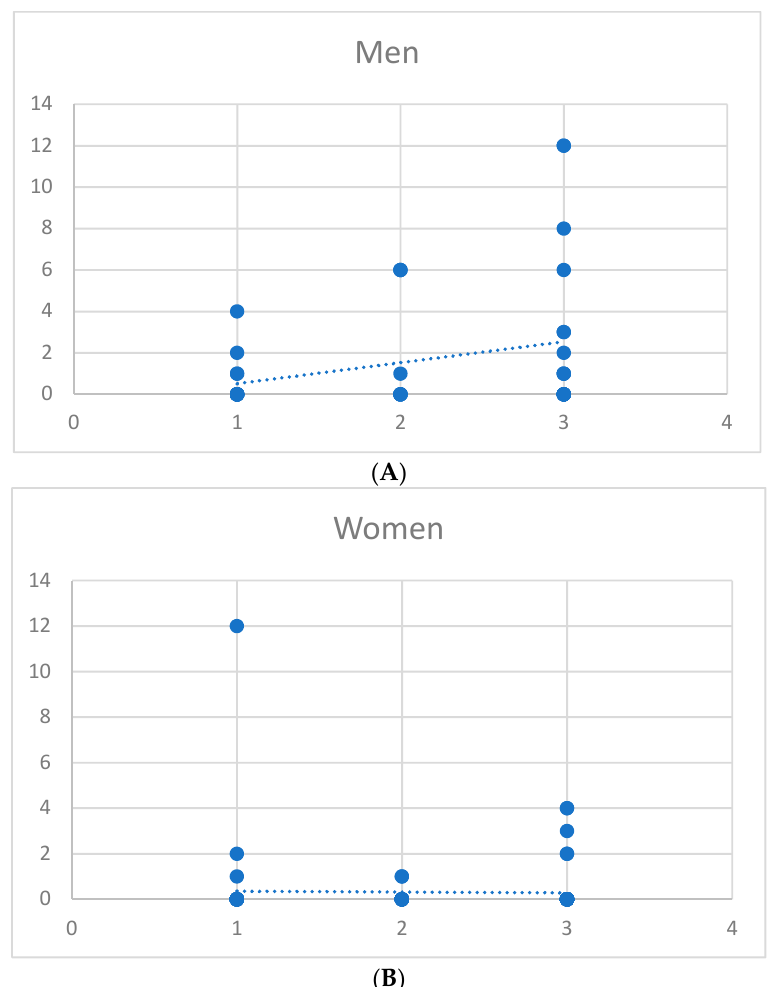
Figure 1. Correlation between number of psychiatric disorders and amount of alcohol drinking in African American men ( A ) and African American women ( B ). The x axis shows the number of psychiatric disorders and the y axis is the amount of alcohol use.